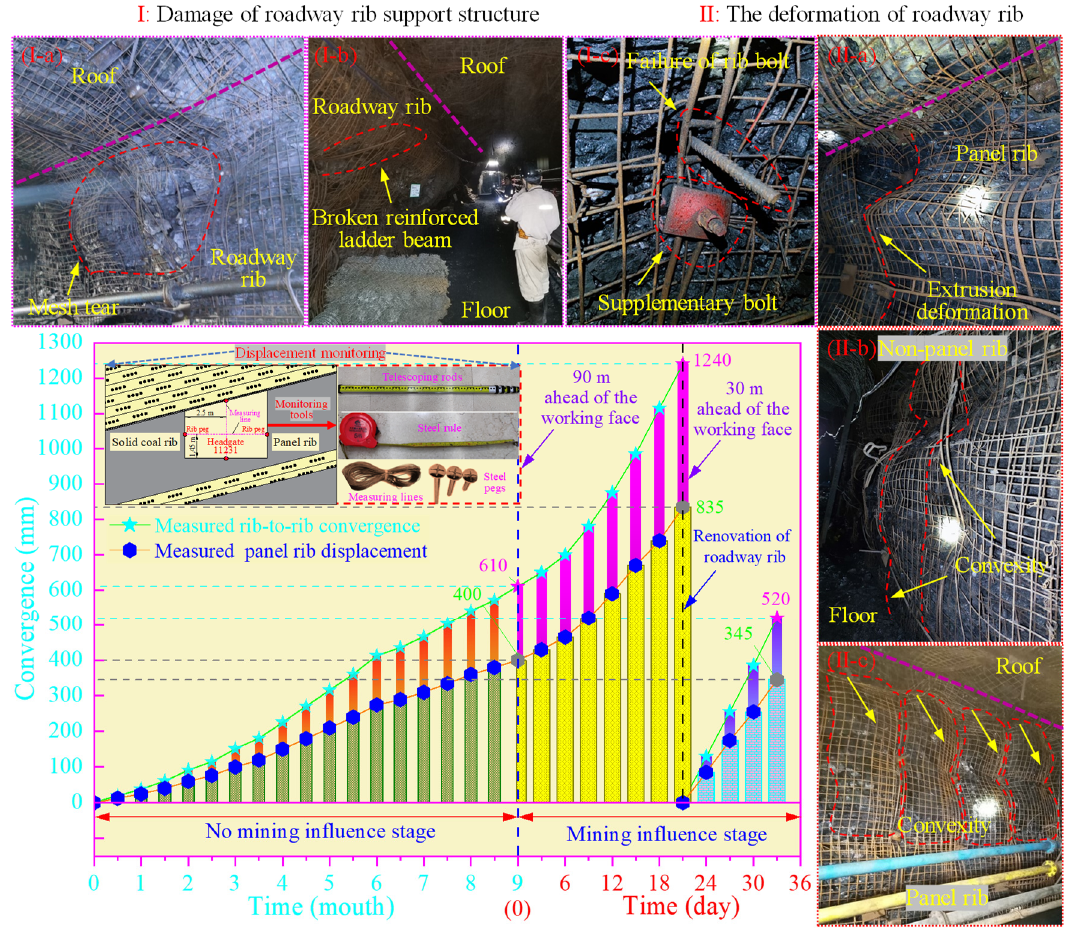
Figure 4. Deformation overview of the two ribs of headgate 11231 surrounding rock. ( I-a ) Tearing of metal mesh; ( I-b ) Large deformation of roadway rib; ( I-c ) Anchor bolt failure; ( II-a ) Large deformation of the panel rib; ( II-b ) Large deformation of non-panel rib; ( II-c ) Roadway rib bulges out.